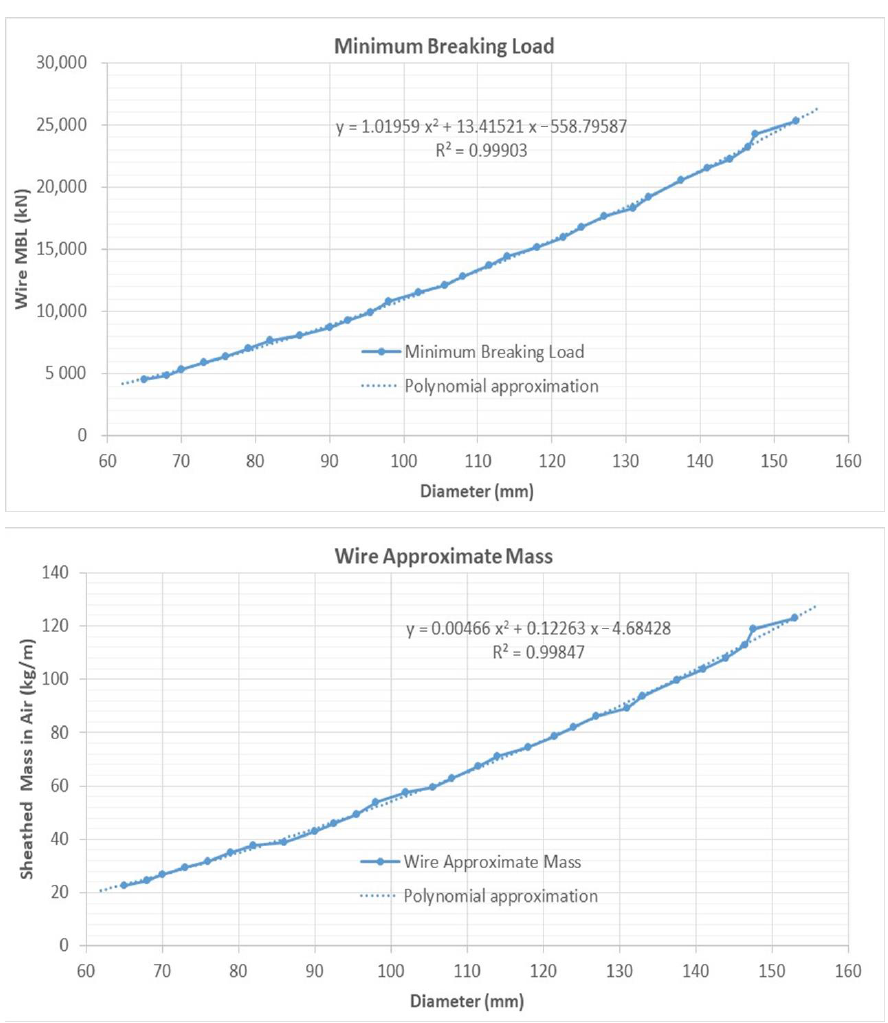
Figure 3. The estimated MBL ( top ) and mass ( bottom ) of the steel wire in terms of diameter.